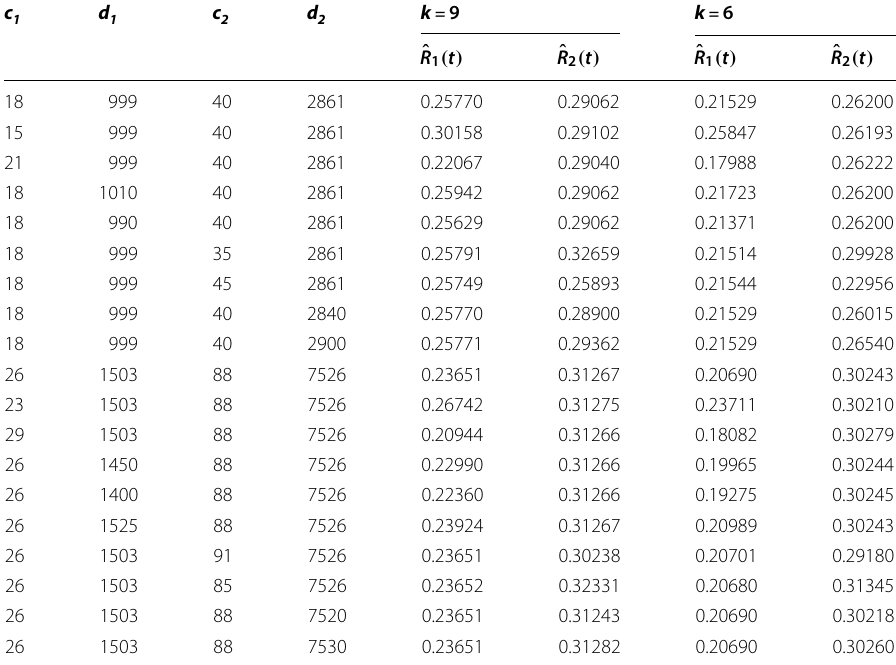
Table 8 Bayes estimates of reliability at time t